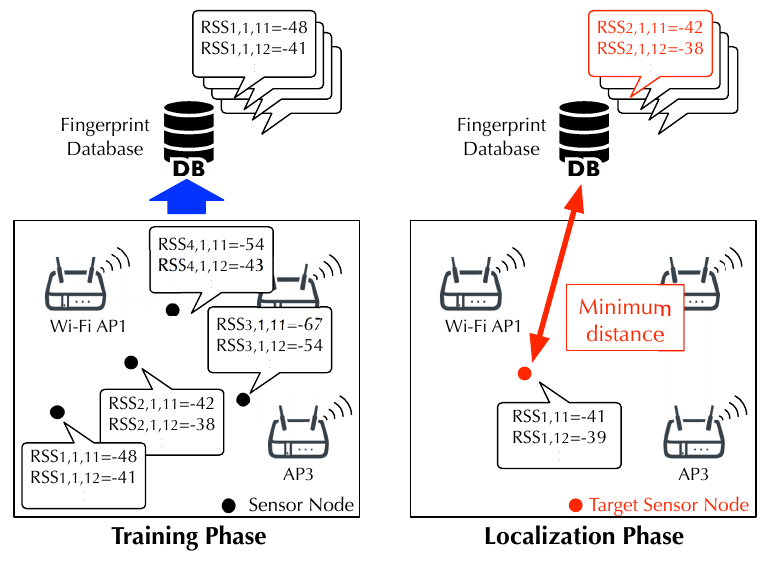
Figure 4. Overview of fingerprint localization